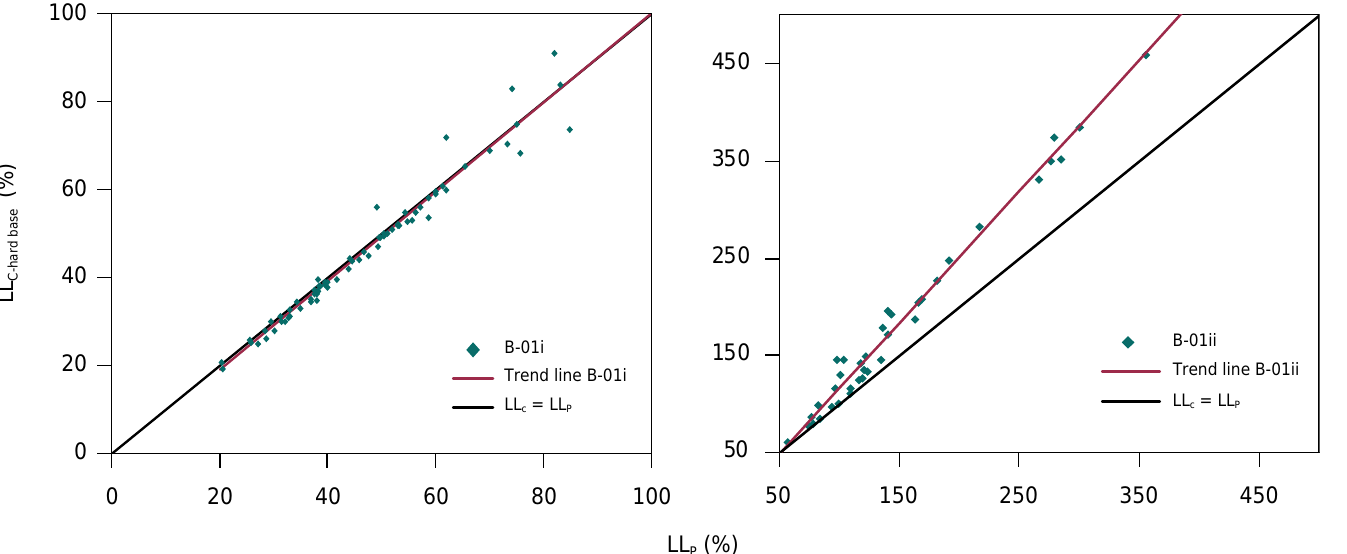
Figure 6. Trend lines of the experimental results, LL p -LL c-hard base , of the soils investigated in group B-01: subgroup B-01i (kaolinites and illites) with 20< LL c <100 % (a); and subgroup B-01ii (smectites) with 50< LL c <460 %